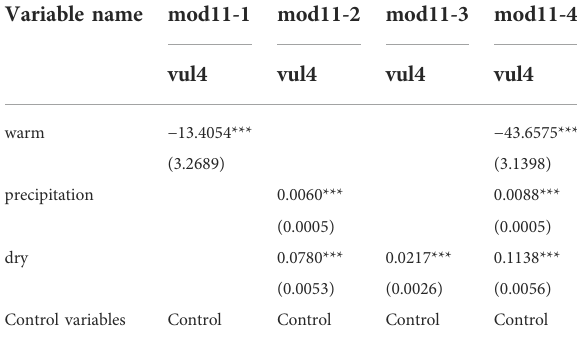
TABLE 11 Constrained logit regression estimation results (poor = USD 3.1/day/person). Variable name